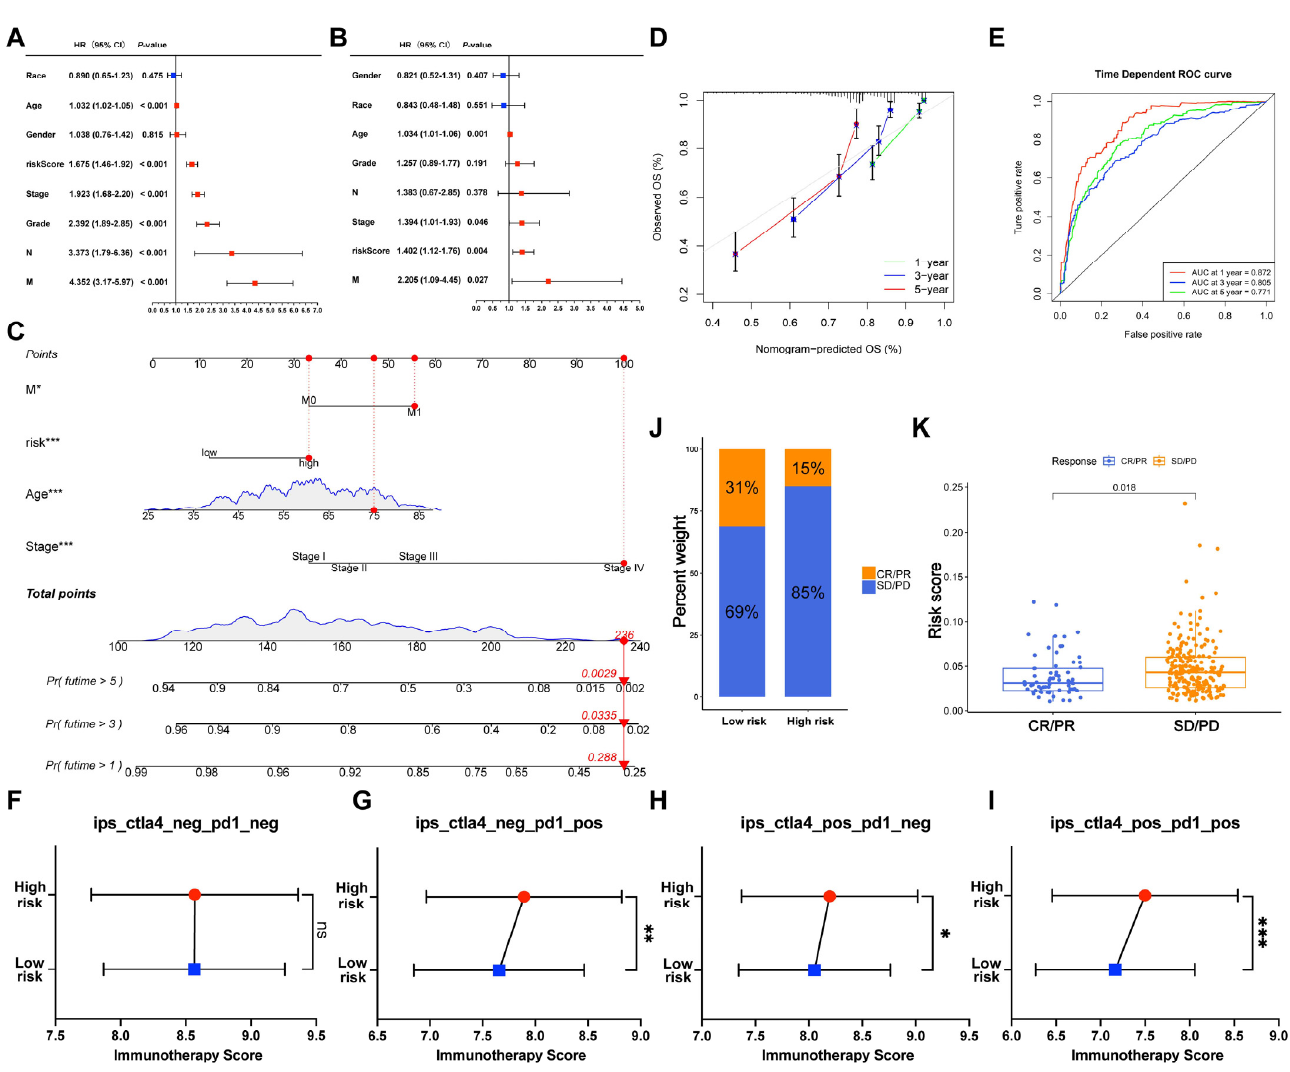
Figure 11. Construction of the nomogram and the predictive power of the RMC-based signature in immunotherapy response. Univariate ( A ) and multivariate ( B ) Cox regression analyses identified the pathological stage, M stage, age, and risk score as independent prognostic factors. ( C ) A nomogram was established according to the selected independent prognostic factors. The calibration diagram ( D ) and ROC curve ( E ) show the performance of the nomogram in predicting prognosis after 1, 3, and 5 years. ( F – I ) The differing sensitivity of the high- and low-risk patients subjected to anti-PD-1 and anti-CTLA-4 immunotherapy. ( J ) The proportions of patients who responded to anti-PD-L1 immunotherapy in the high- and low-risk groups in the IMvigor210 dataset. CR, complete response; PR, partial response; SD, stable disease; PD, progressive disease. ( K ) The ability of the risk score model to predict anti-PD-L1 immunotherapy response. * p < 0.05, ** p < 0.01, *** p < 0.001; ns,